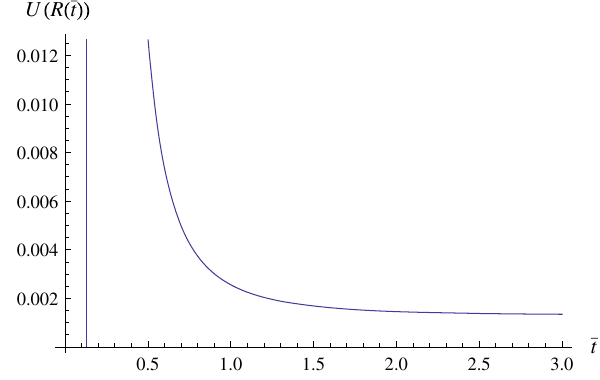
Fig. 13 The evolution of ¯ U ( ˆ R ( ¯ t )) in the Einstein frame in the case when the evolution of the universe starts from the generalized sudden singularity. For illustration it is assumed that f ( ˆ R ) = ˆ R + γ ˆ R 2 + δ ˆ R 3 , (cid:3) (cid:4) (cid:3) (cid:4) s 2 Mpc 2 s 4 Mpc 4 and δ = 10 − 13 . Note that for the where γ = 10 − 9 km 2 km 4 late time the potential ¯ U ( ¯ t ) goes to a constant value at late time. Time is expressed in unts of s Mpc and ¯ U ( ˆ R ( ¯ t )) is expressed in units of 10 4 km 2 100 km s 2 Mpc 2